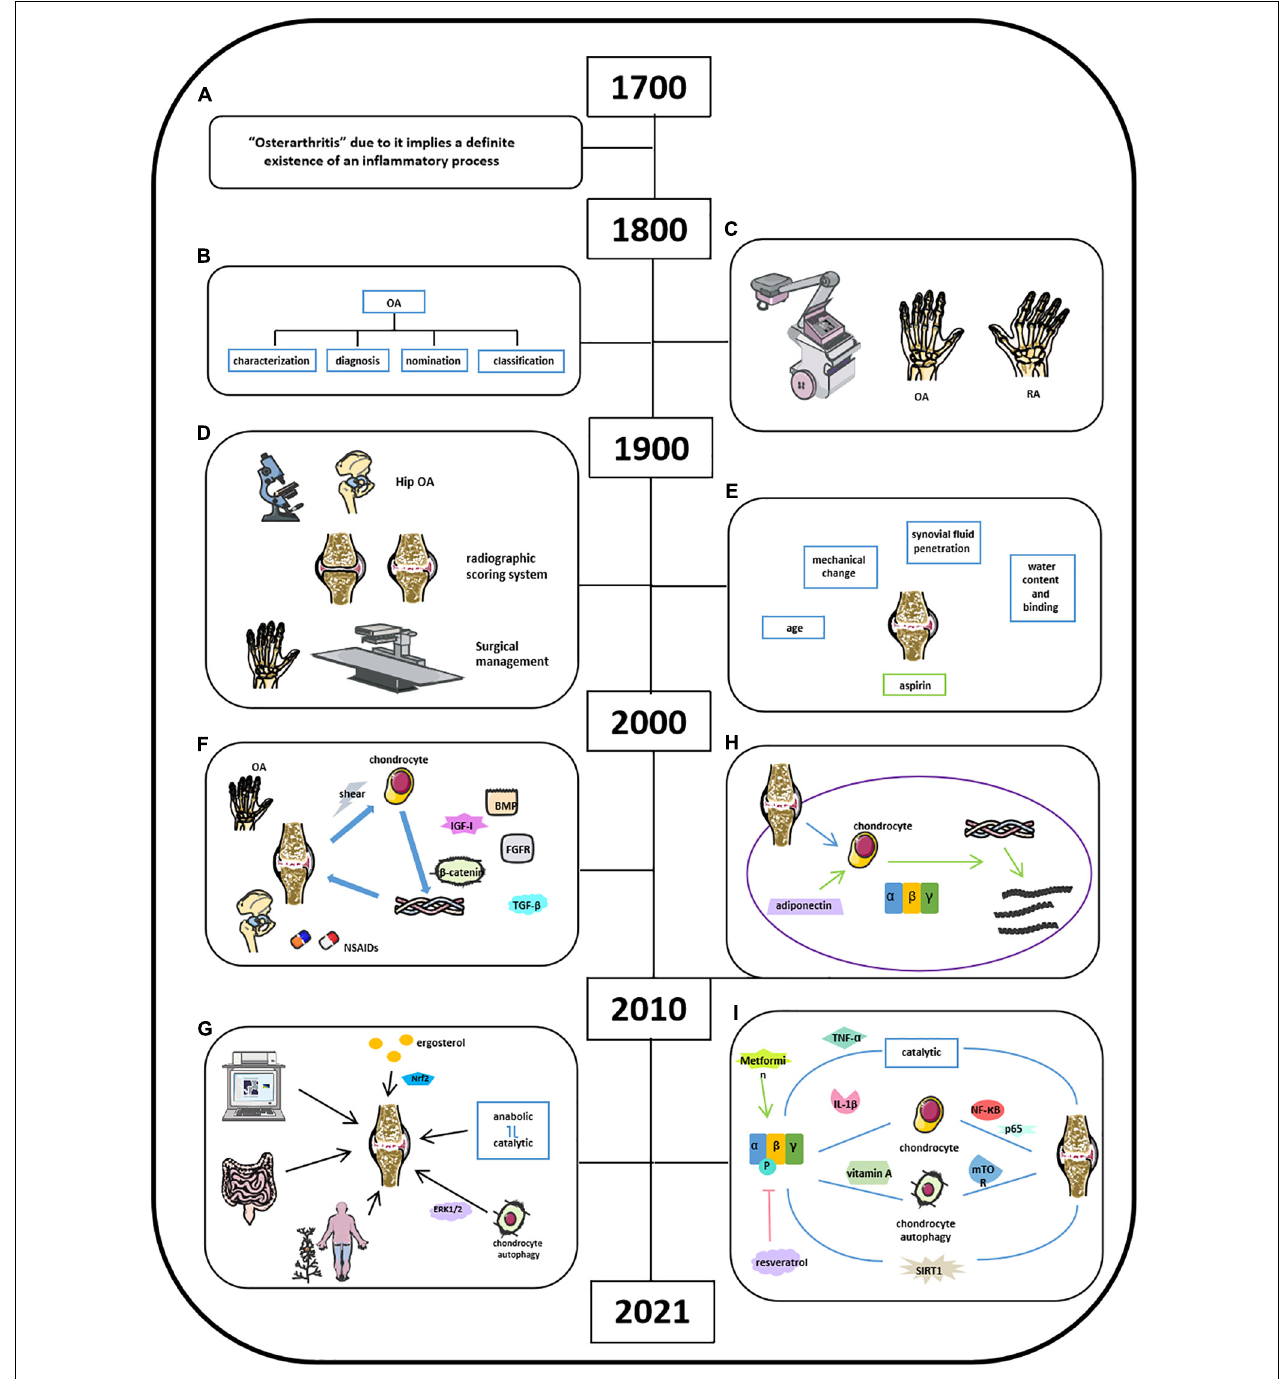
FIGURE 4 | Milestones of discoveries of osteoarthritis and the role of AMPK in cartilage regeneration. (A) Physicians recognize the inflammatory process of OA by 18th century. (B) In 19th century, the knowledge of clinical OA became comprehensive. (C) X-rays applied in clinics helped Goldthwait distinguish OA from rheumatic arthritis (RA). (D) In 1900s, light microscope and electron microscope helped physicians in knee and hip OA treatment. (E) Knowledge of OA related in age, mechanical change, synovial fluid penetration, and water content binging. (F) NSAIDs and some herbal medicines were used to treat OA or relieve OA-related pain; activation of cartilage anabolic factors was associated with the degradation of proteoglycans, collagen type II, and cleaving matrix metalloproteinase. (G) Comprehensive understanding of OA by 2021. (H) Adiponectin mediates matrix degradation in human OA chondrocytes via AMPK and JNK pathways. (I) Molecules involved in OA